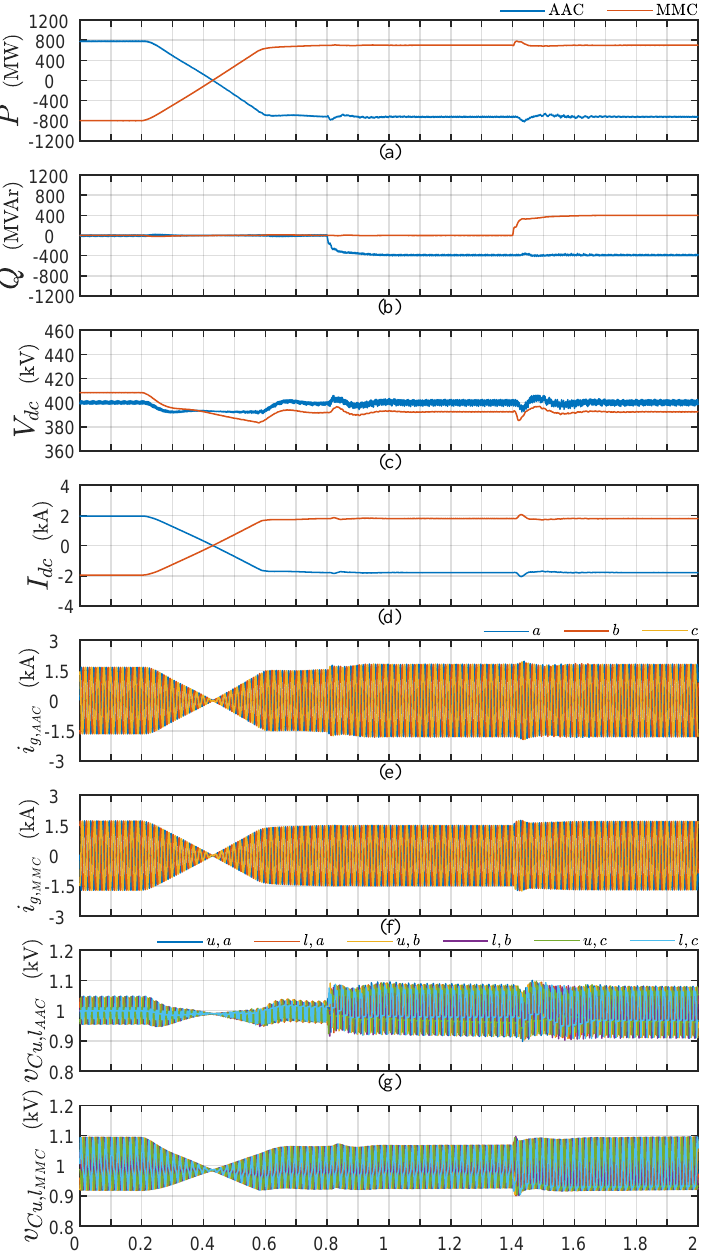
Figure 8. Power reversal (at 0.2 s) and reactive power step changes (AAC at 0.8 s and MMC at 1.4 s): ( a ) active power, ( b ) reactive power, ( c ) dc voltage, ( d ) dc current, ( e ) ac currents of AAC, ( f ) ac currents of MMC, ( g ) SM capacitor voltages of AAC, and ( h ) SM capacitor voltages of MMC. The SM capacitor voltage deviations of both the AAC and MMC (Figure 8g,h) are insignificant during power reversal. This demonstrates the energy balancing capability of the AAC and proper capacitor voltage regulation of the MMC by utilizing circulating current control techniques [24,32]. Only the capacitor voltage ripples are affected by the reactive power but are contained within the designed ± 10% limit. The ac and dc side voltages and currents of the hybrid HVDC system show that the impact of disturbances in one terminal on the other is insignificant and does not lead to larger energy deviations and unstable operation of the